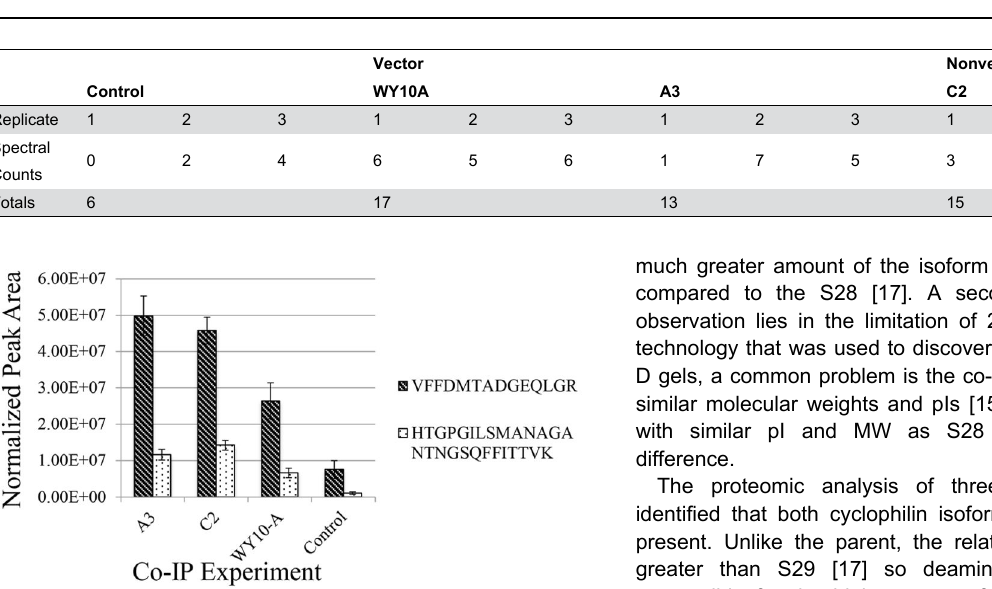
Table 3. Cyclophilin spectral counts in the coIP with CYDV-RPV and Schizaphis graminum proteins show more than 2-fold enrichment compared to negative